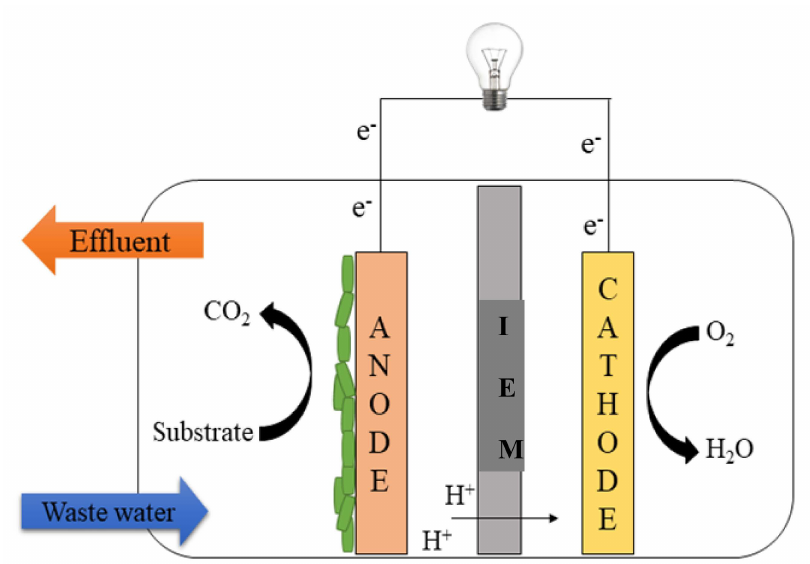
Figure 5. A schematic representation of an experimental set-up of a dual-chambered